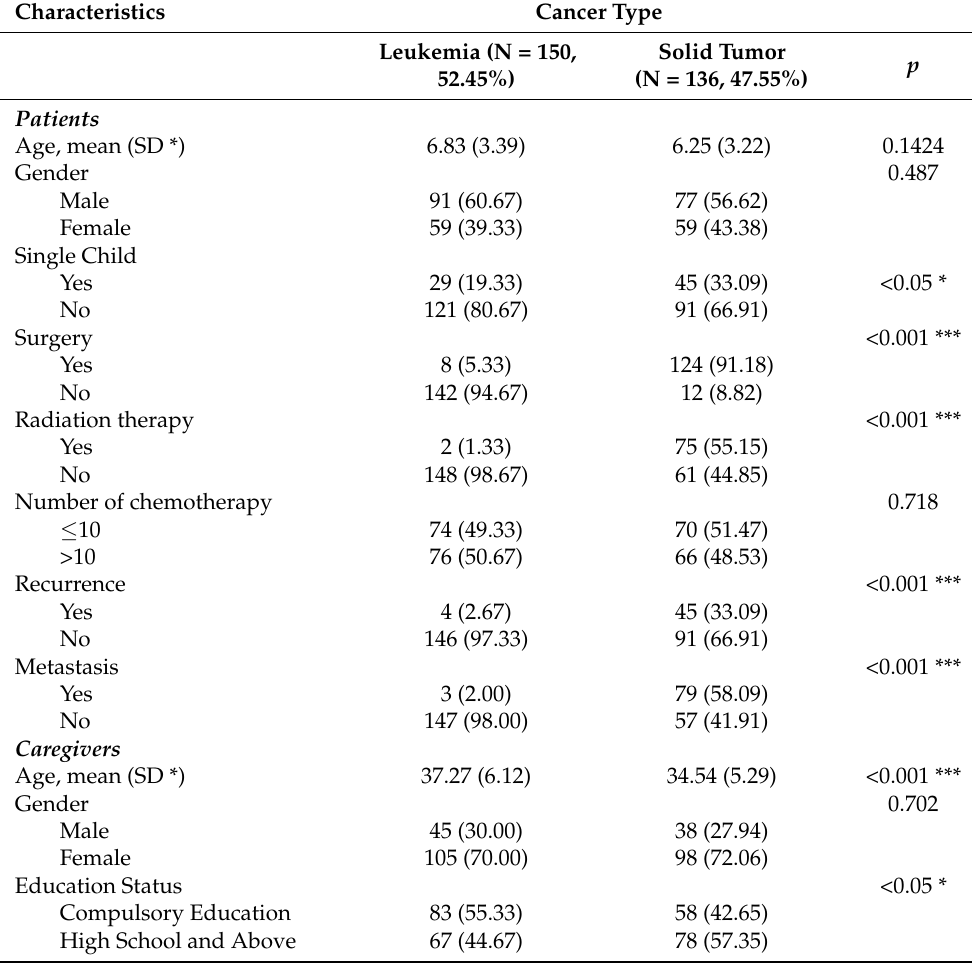
Table 1. Characteristics of childhood cancer patients and their caregivers based on cancer type (N = 286). Characteristics Cancer Type Leukemia (N = 150,